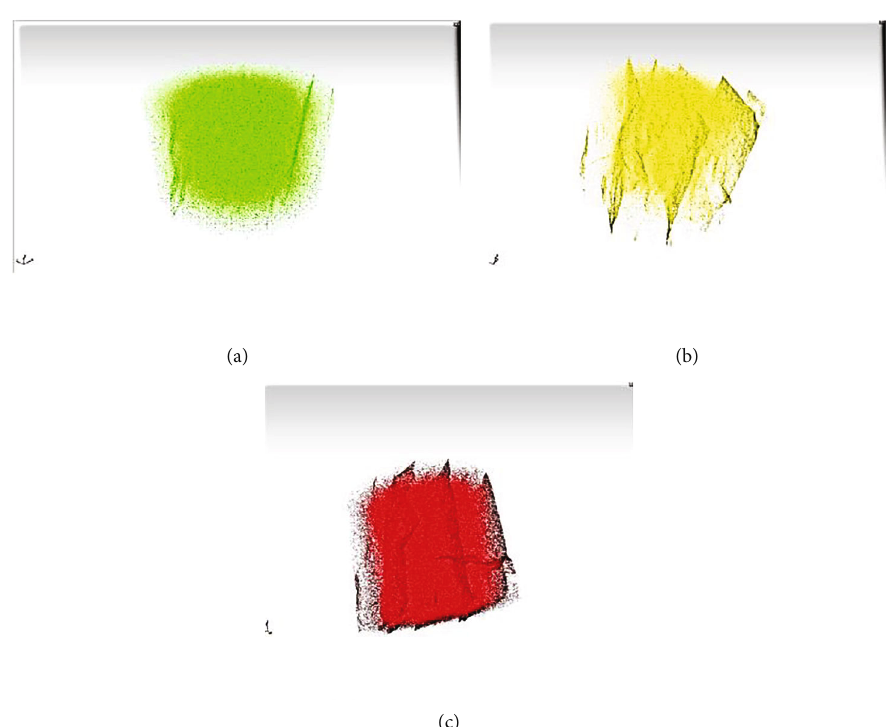
Figure 9: CT scanning results of Well N2 core immersed in the liquids. (a) Dry sample. (b) Sample immersed in the water for 10 d. (c) Sample immersed in the fl owback fl uid for 10d.